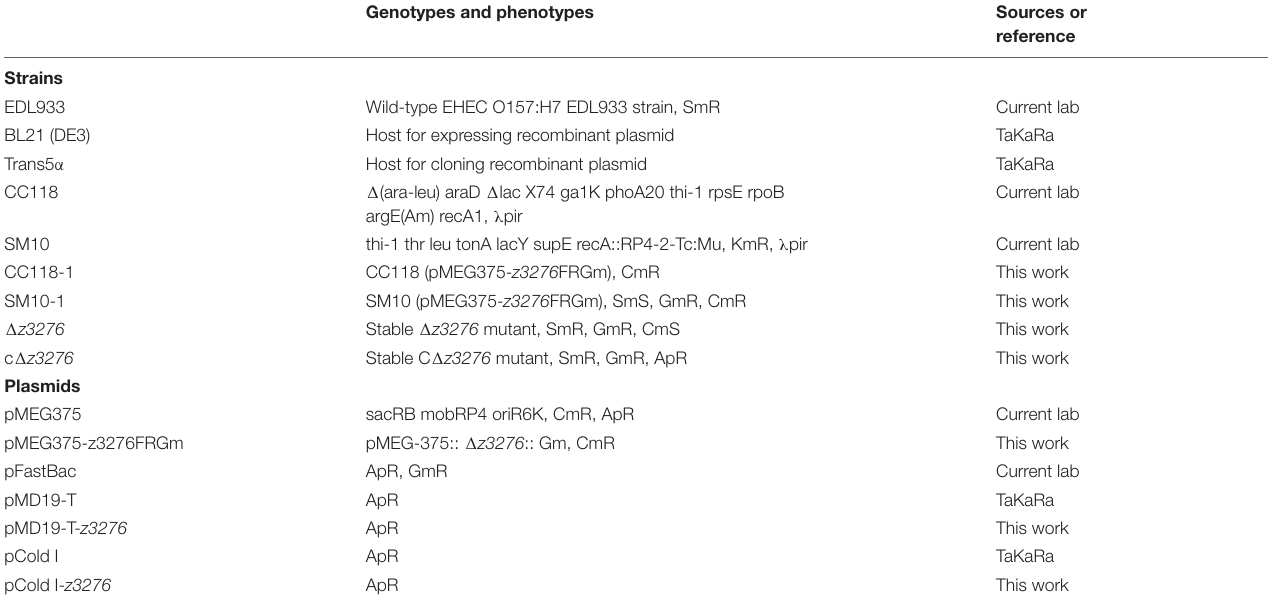
TABLE 1 | Bacterial strains and plasmids used in this